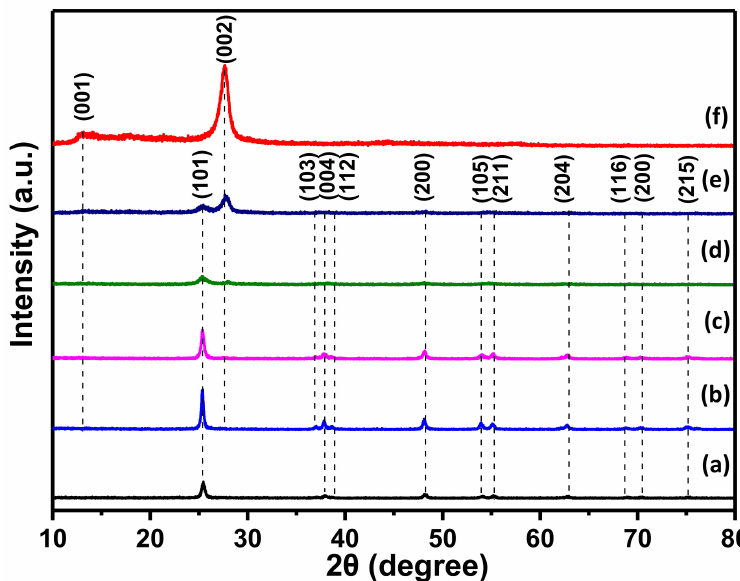
Figure 2. XRD patterns of ( a ) TiO 2 nanofibers; ( b ) CNT1; ( c ) CNT3; ( d ) CNT5; ( e ) CNT6 and ( f ) g-C 3 N 4 synthesized at 550 ◦